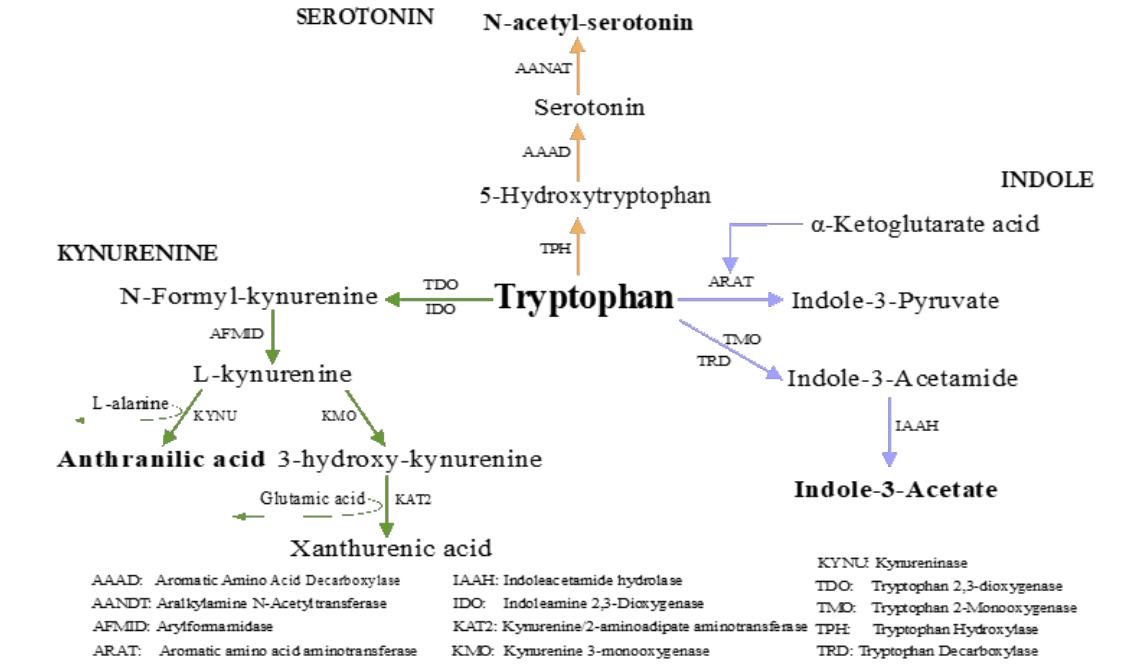
Figure 1. Schematic representation of the identified metabolites separated by the three major tryp- tophan pathways. The metabolites changed three months after RYGB are highlighted in bold. Sta- tistical significance p < 0.05.